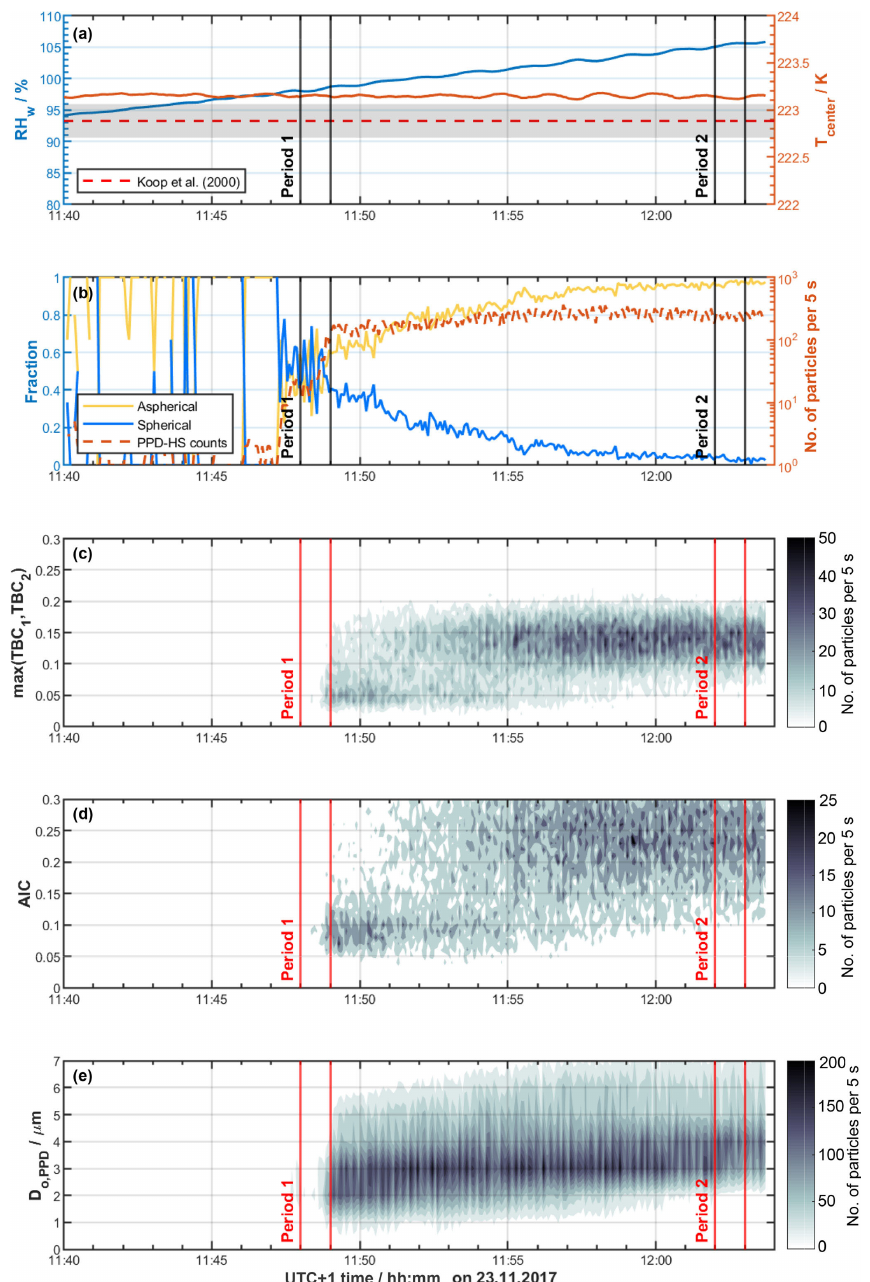
Figure 7. Freezing experiments of NH 4 NO 3 aerosol using HINC at T = 223K and a residence time τ = 22s. (a) RH w (blue line, left-hand ordinate) along with T center at HINC center line (orange line, right-hand ordinate), where aerosol particles are injected and hydrometeors are formed. (b) Classification of particles detected by PPD-HS (left-hand ordinate) using the random forest model (see Sect. 3.2) along with the total number of detected particles (dashed orange line, right-hand ordinate). (c) Distribution of maximum TBC value and (d) AIC value of PPD-HS scattering patterns. (e) PPD-HS optical particle size distribution obtained from RT electronics. Vertical solid lines indicate starting and end times of periods of interest,